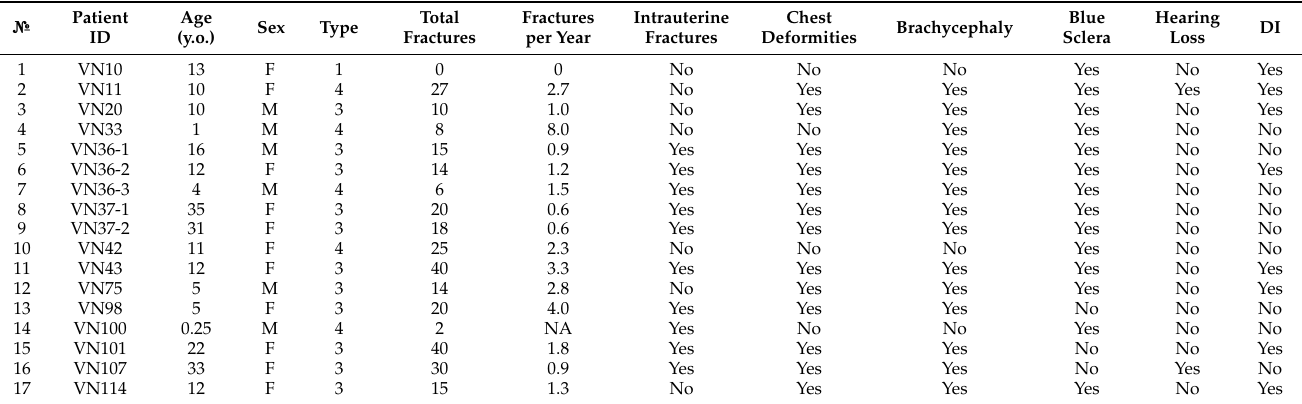
Table 1. Clinical characteristics of patients with prolyl 3-hydroxylase 1 ( P3H1 ) (pathogenic) variants.